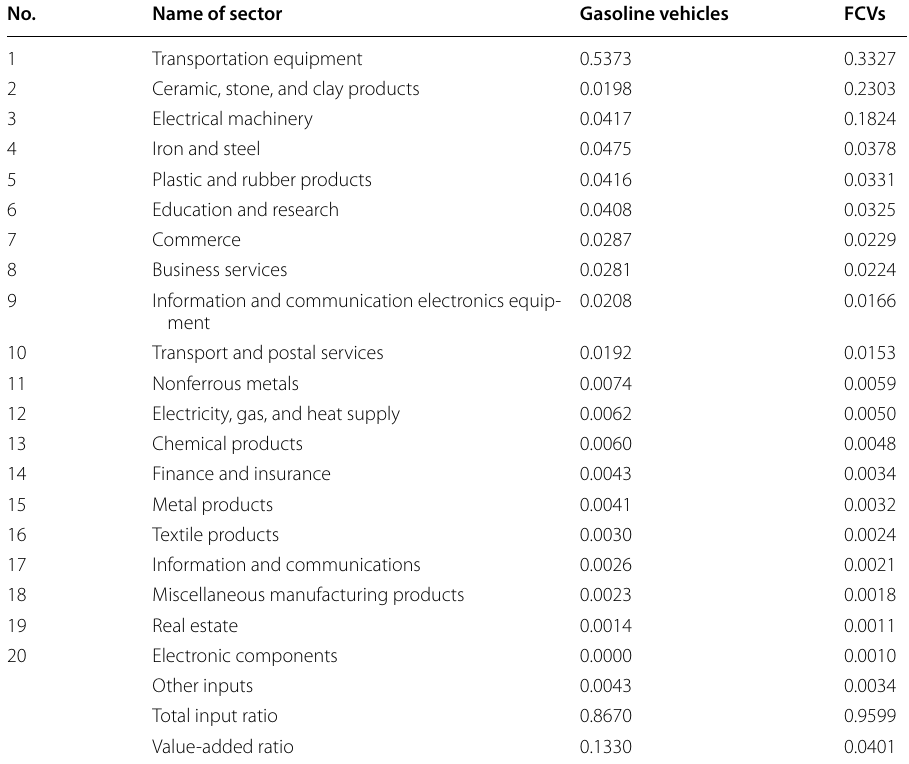
Table 6 Estimated input coefficients in gasoline vehicles and FCVs. Source : Authors’